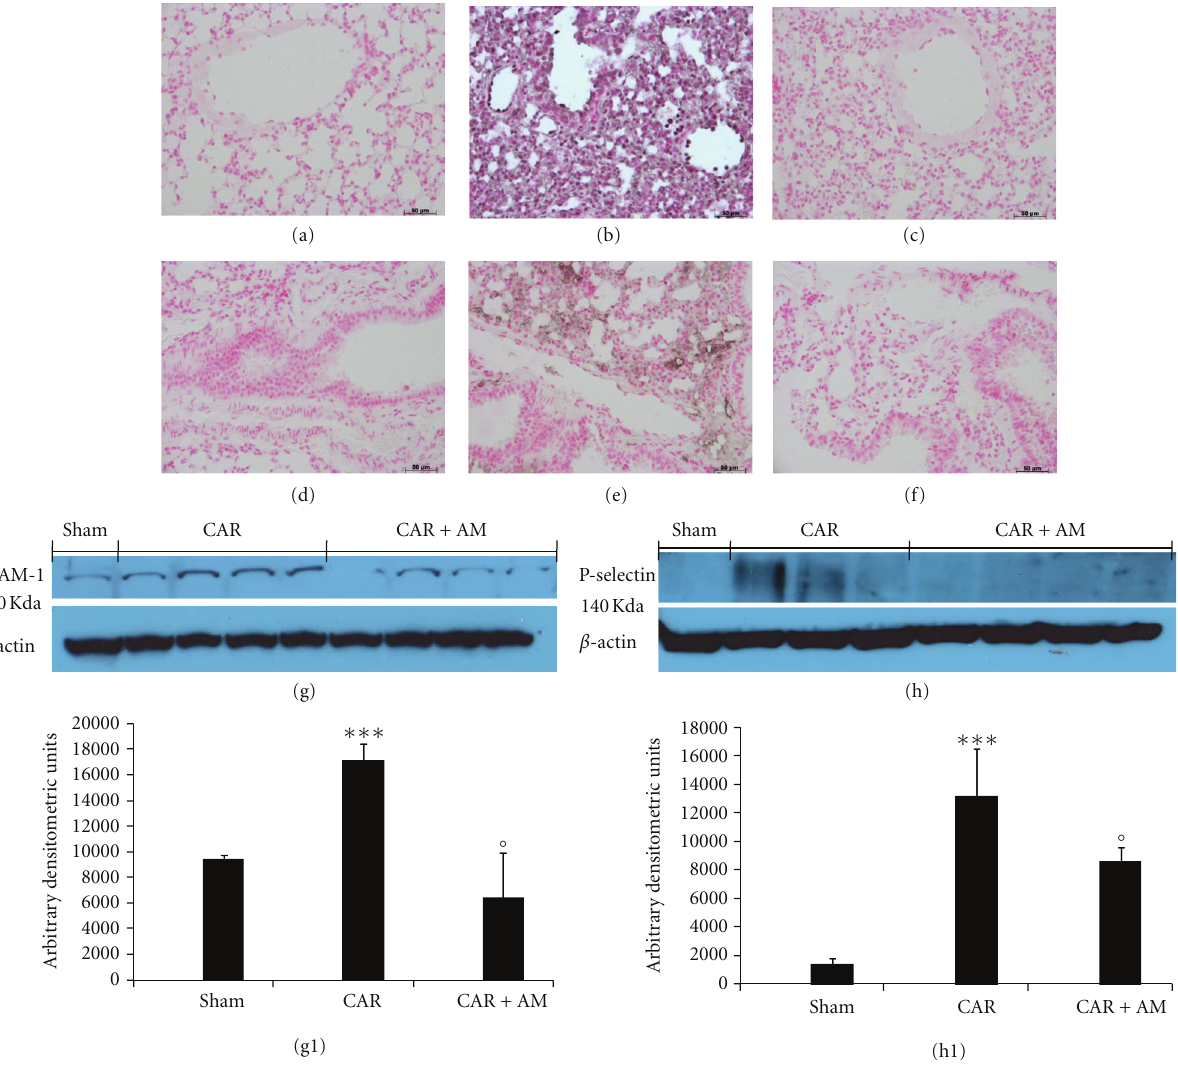
Figure 2: E ff ect of adrenomedullin (AM) on the immunohistochemical localization of ICAM-1 and P-selectin. No positive staining for ICAM-1 was observed in lung sections taken from sham mice treated with AM (a). Lung sections taken from CAR-treated mice showed intense positive staining for ICAM-1 along the vessels (b). The degree of positive staining for ICAM-1 was markedly reduced in lung sections obtained from mice treated with AM (c). No positive staining for P-selectin was observed in lung sections taken from sham mice (d). Lung sections taken from CAR-treated mice treated with vehicle showed intense positive staining for P-selectin along the vessels (e). The degree of positive staining for P-selectin was markedly reduced in tissue sections obtained from mice treated with AM (f). The figure is representative of at least three experiments performed on di ff erent experimental days. A significant increase in ICAM (g, g1) and P-selectin (h, h1) quantification, assayed by western blot analysis, was detected in lungs obtained from mice subjected to CAR-induced pleurisy, if compared with lung from sham mice (g, g1 and h, h1). Treatment with AM significantly attenuated these proteins quantification in the lung tissues (g, g1 and h, h1). A representative blot of lysates obtained from 5 animals per group is shown and densitometry analysis of all animals is reported. The results in panel (g1) and (h1) are expressed as mean ± s.e.m. from n = 5 / 6 lung tissues for each group. ∗ P < 0 . 01 versus sham group. ◦ P < 0 . 01 versus